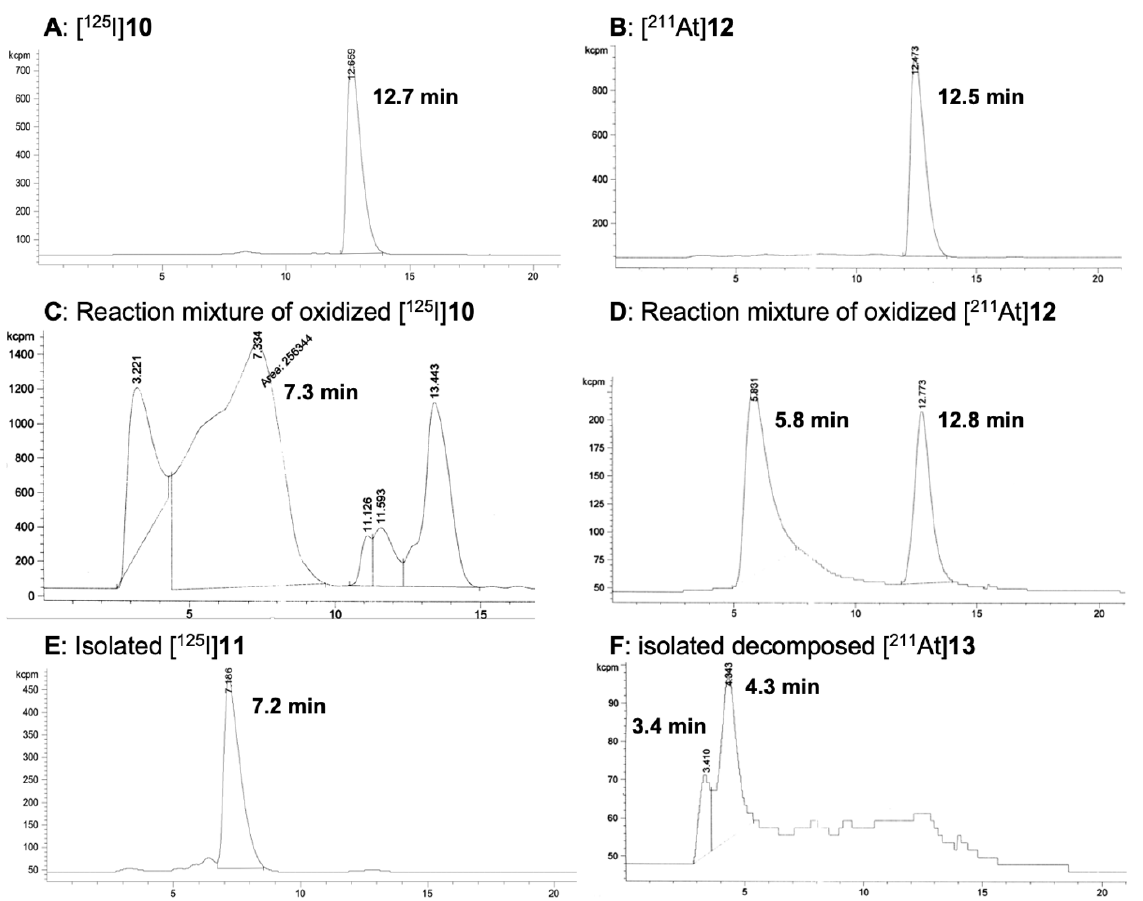
Figure 4. Radiochromatograms of reaction solutions and isolated products in the preparation of [ 125 I] 11 and [ 211 At] 13 for animal biodistributions. (Panel A ) Reaction solution containing [ 125 I] 10 ; (Panel B ) Reaction solution containing [ 211 At] 12 ; (Panel C ) Reaction mixture from oxidation of [ 125 I] 10 ; (Panel D ) Reaction mixture from oxidation of [ 211 At] 12 ; (Panel E ) [ 125 I] 11 in PBS after isolation from HPLC; (Panel F ) Isolated products in PBS from oxidation of [ 211 At] 12 (note that the desired product in panel D at 5.8 min decomposed on isolation).